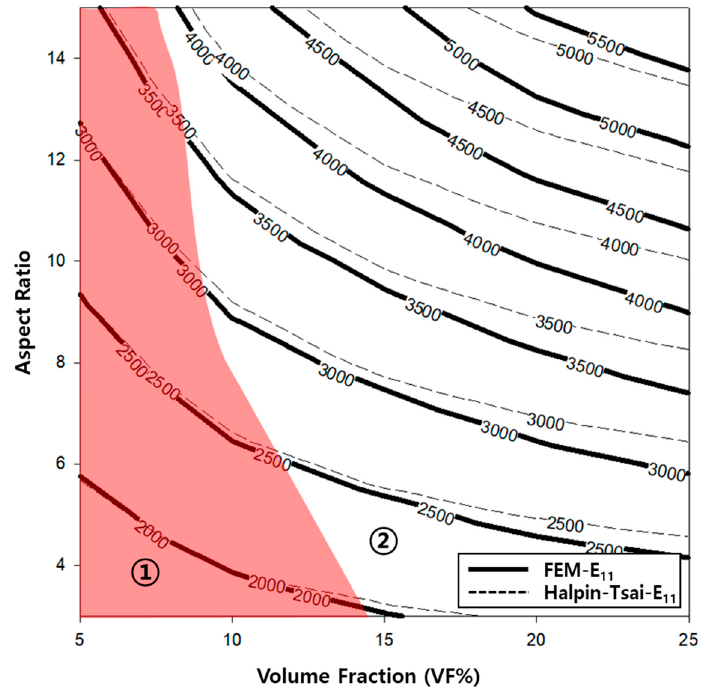
Figure 6. Contour graph showing elastic modulus (E 11 ) as functions of the volume fraction and aspect ratio.